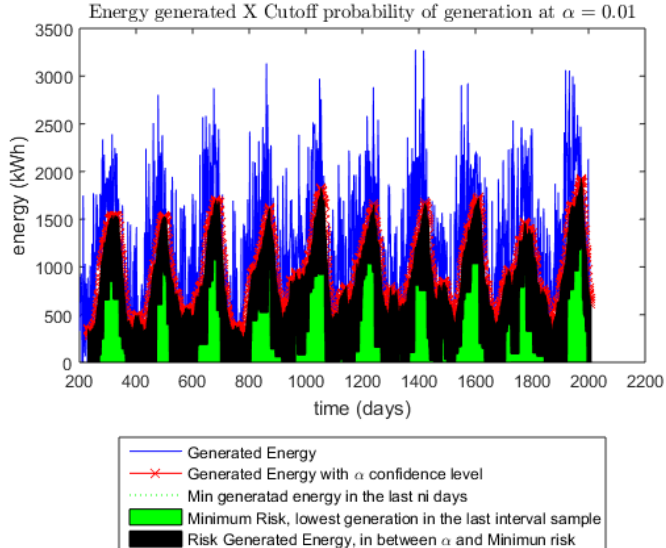
Figure 6. Ten years Wind Behavior—real generation and the generation